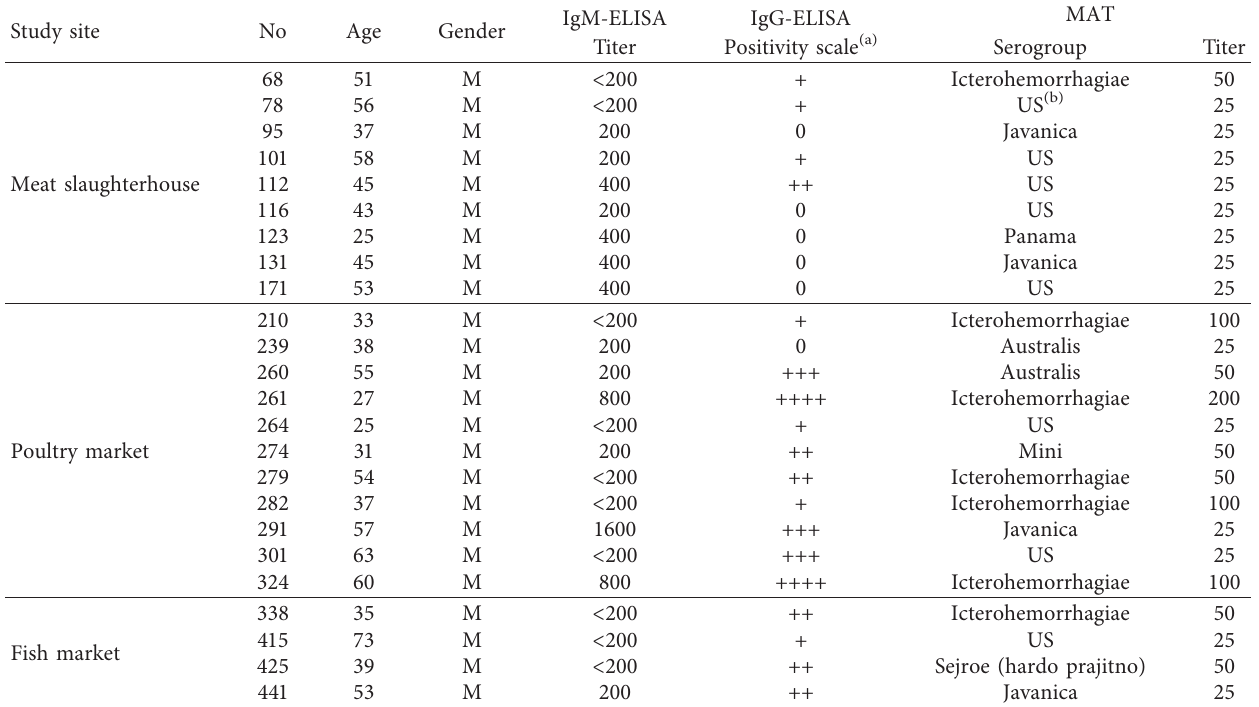
Table 5: Distribution of leptospiral serovars in the various occupational groups with the highest titers as determined by MAT. Study